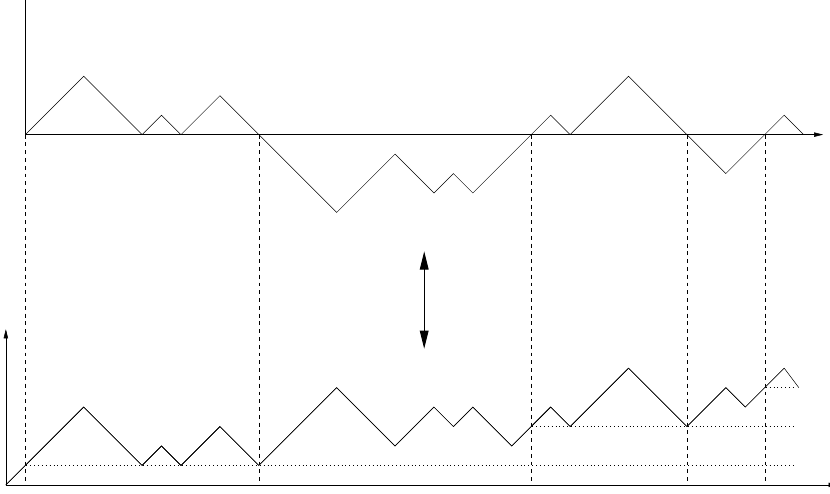
Fig. 3: The bijection between the bridge and the